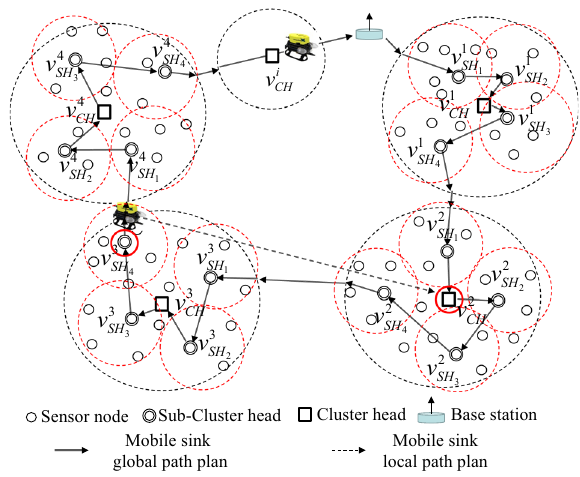
Fig. 5 Global and local-path-plan diagram of mobile